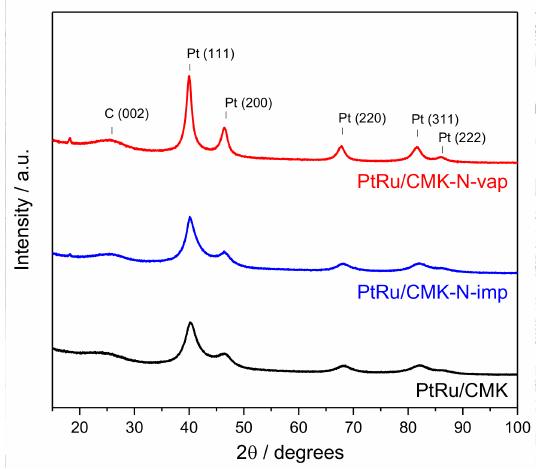
Figure 2. X-ray diffractograms of PtRu